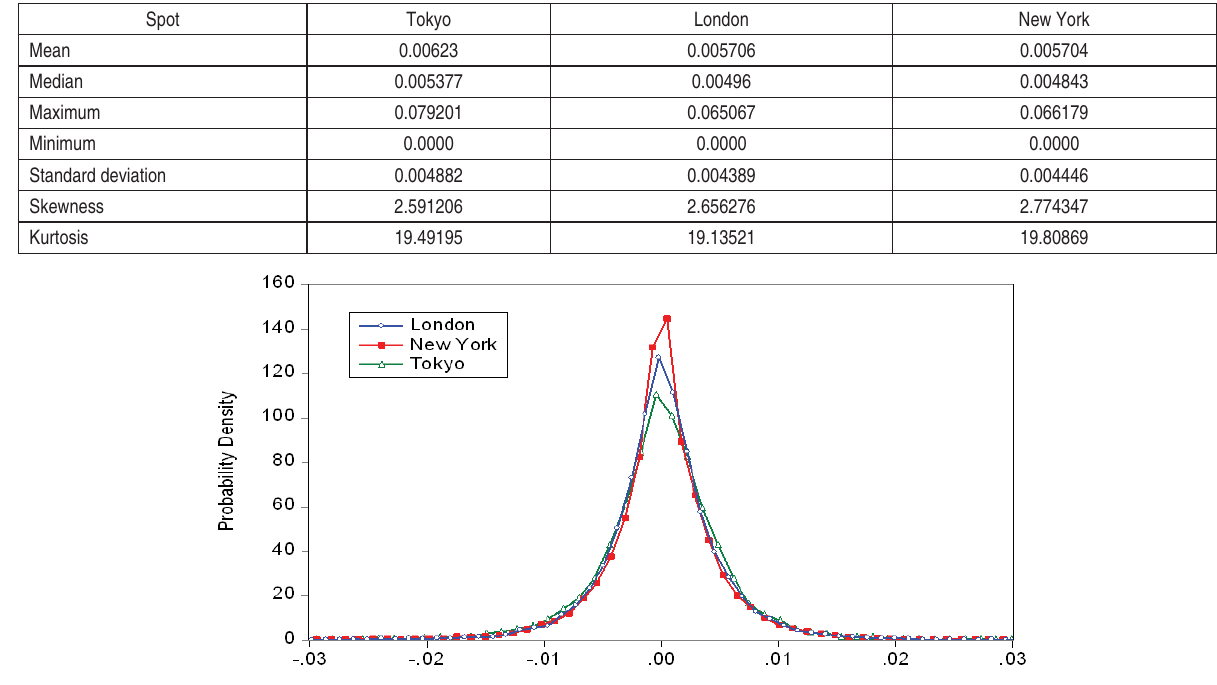
Table 2. Summary statistics of intraday gold volatility in Tokyo, London, and New York